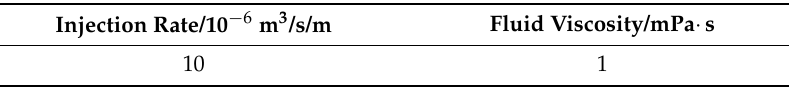
Table 2. Operational